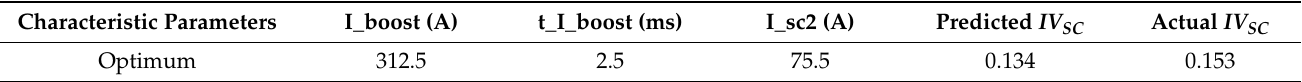
Figure 12. Response surface of I_ boost, t_ I_boost and IV SC at di ff erent I_sc2: ( a ) I_sc2 = 58 A; ( b ) I_sc2 = 70 A; ( c ) I_sc2 = 82 A. Table 8. Optimization of the CMT characteristic parameters and the corresponding IV SC